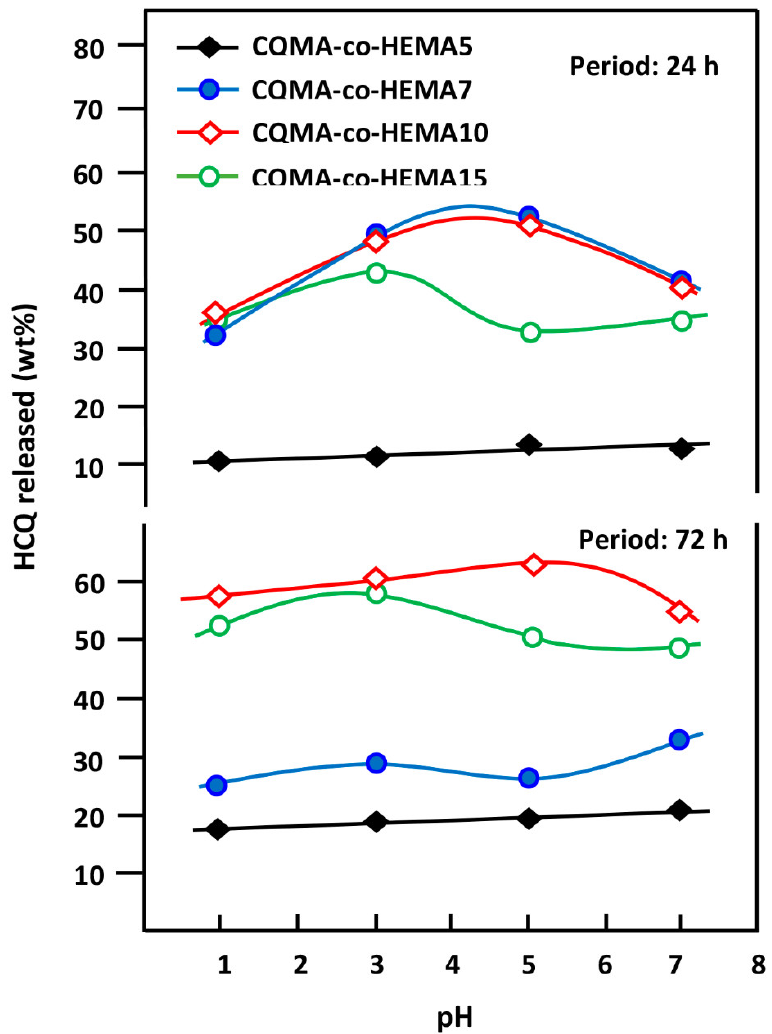
Figure 19. Variation of the cumulative HCQ released from the CQMA- co -HEMA drug carrier systems versus the media pH.